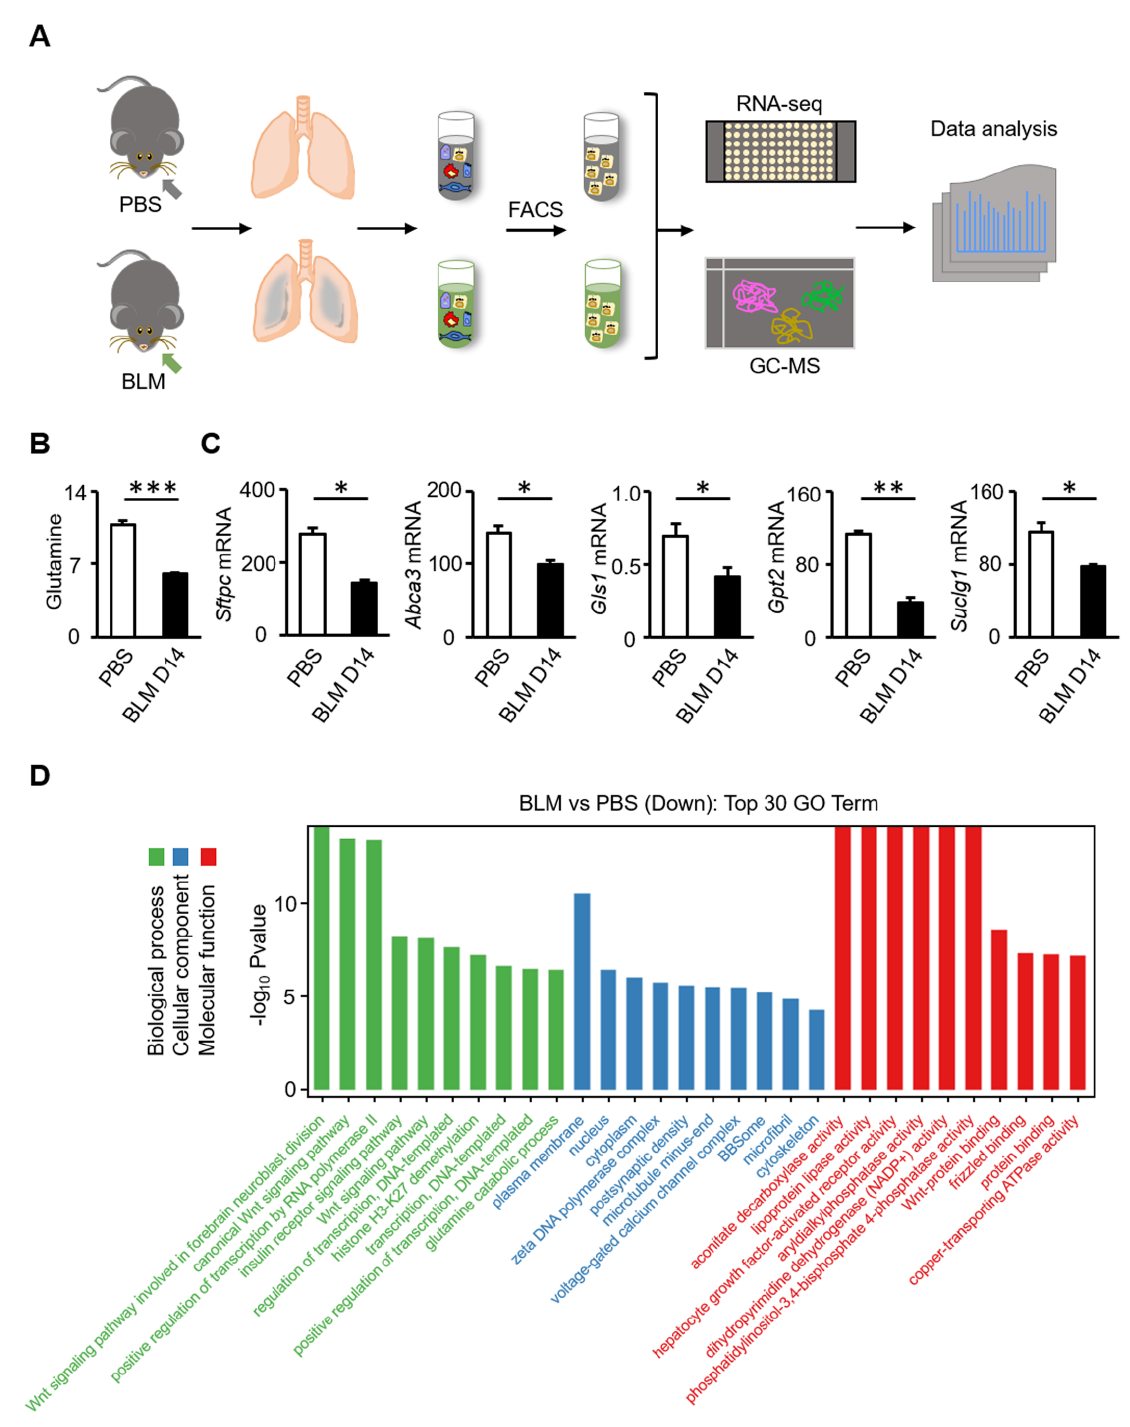
Figure 2. Glutamine metabolic pathway is inhibited in AT2 cells of bleomycin-induced fibrosis in mice. ( A ) Overview of experimental design. AT2 cells from mice treated with PBS or bleomycin for 14 days were isolated by FACS to generate a single-cell suspension for both scRNA-seq and metabolomics analyses. ( B ) Expression of glutamine metabolite in AT2 cells was downregulated after bleomycin injury. ( C ) Expression levels of Sftpc , Abca3 , Gls1 , Gpt2 and Suclg1 genes in AT2 cells were decreased after bleomycin injury. ( D ) Top 30 most enriched Gene Ontology (GO) terms of downregulated differentially expressed genes (DEGs). * p < 0.05, ** p < 0.01, *** p < 0.001.